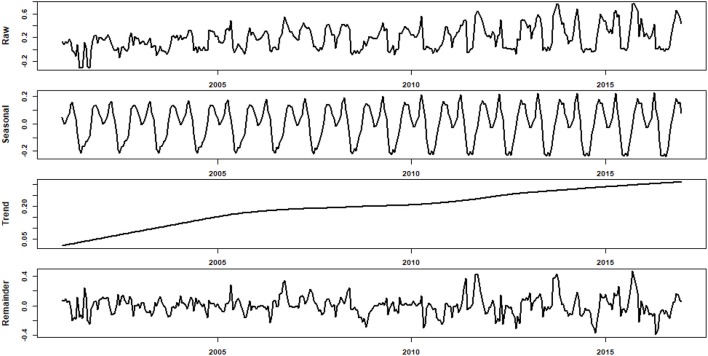
The raw, decomposed seasonal, trend, and remainder of a typical EVI time series at a typical connected site. The EVI continuously increased for the entire study period, and the seasonality also showed an increasing trend.